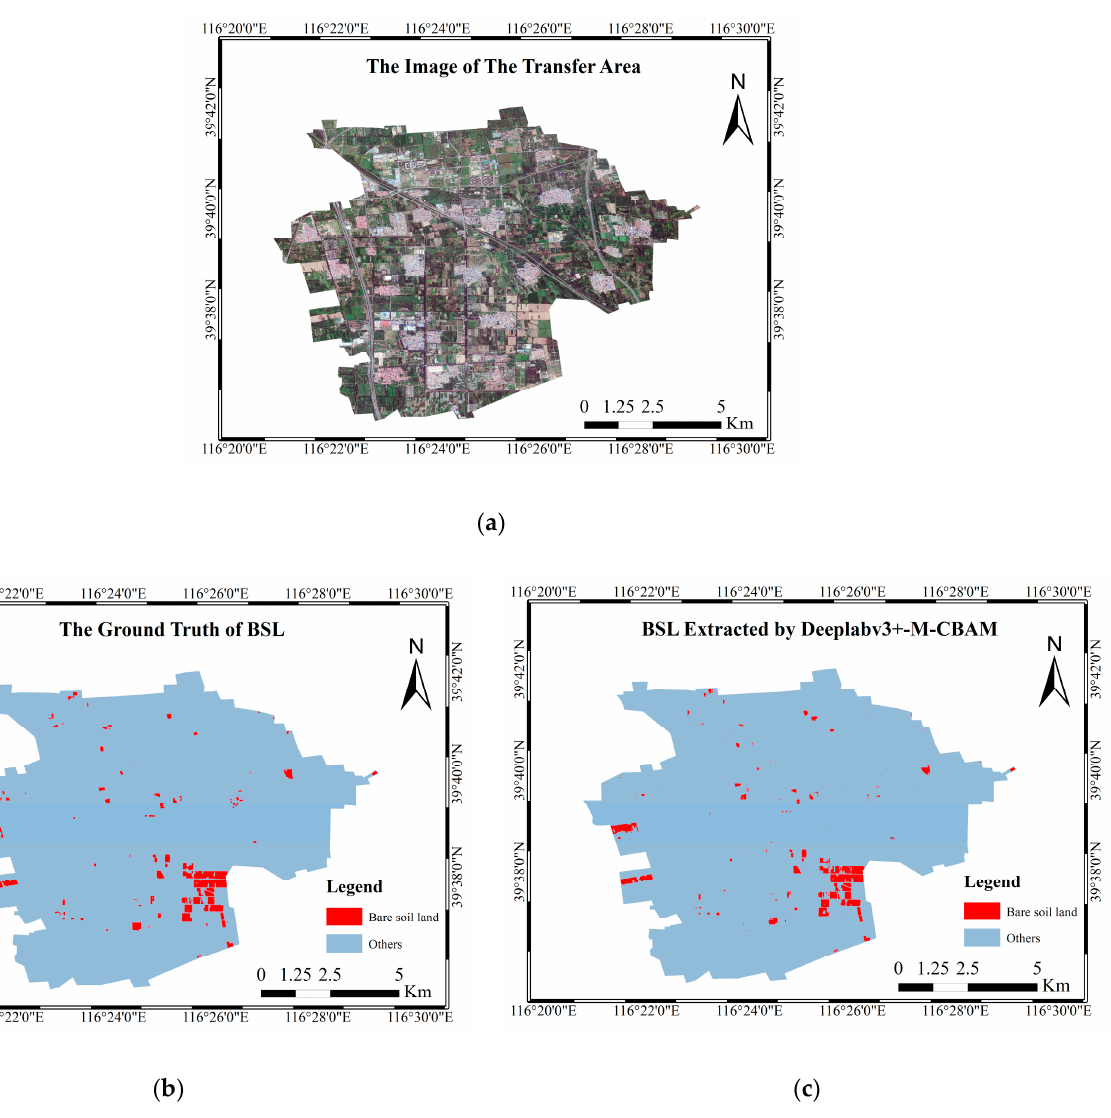
Figure 14. The results of the large-scale mapping of BSL in the transfer area by visual interpretation and Deeplabv3+-M-CBAM: ( a ) transfer area; ( b ) ground truth of BSL for the transfer area; ( c ) BSL extraction results using our model. The coordinate system is GCS_WGS_1984.